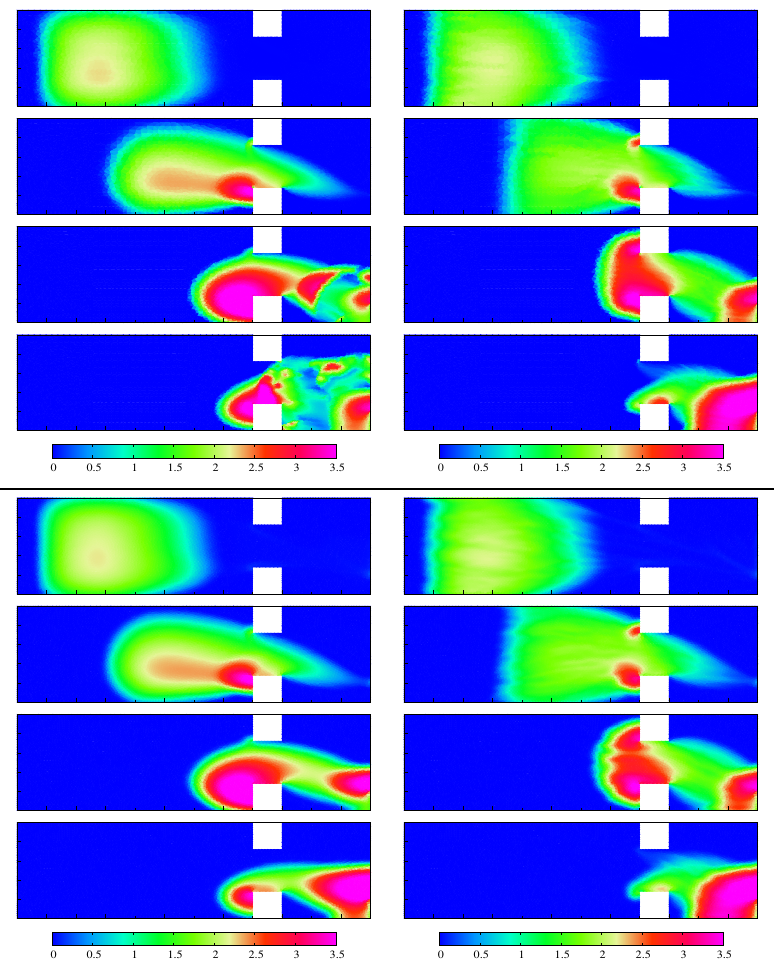
Figure 7. H-shape domain, FV(BR), FV(DA) ( top ) and FV-DG(BR), FV-DG(DA) ( bottom ). Density distribution obtained on the finest meshes at time t = 5,15,30,45 s.